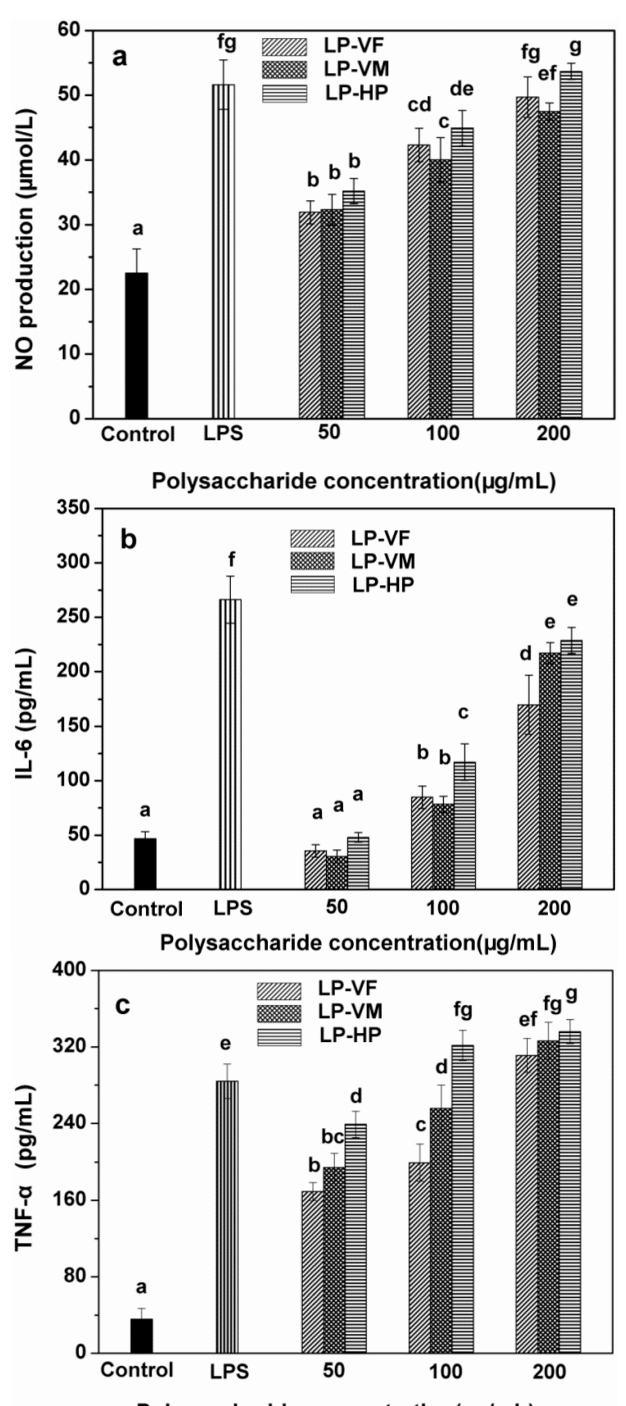
Figure 4. Effects of litchi polysaccharide-protein complexes on the production of NO ( a ), IL-6 ( b ) and TNF- α ( c ) of RAW264.7 macrophages. LPCs (50, 100 and 200 μg/mL) and LPS (5 μg/mL ) were added to stimulate RAW264.7 macrophages. NO, IL-6 and TNF- α were measured by ELISA kits. The results were expressed as the mean ± standard deviation ( n = 6). Bars labeled with different letters represent a statistical difference at p < 0.05. LP-VF: Litchi polysaccharide-protein complexes from vacuum freeze dried pulp; LP-VM: Litchi polysaccharide-protein complexes from vacuum microwave dried pulp; LP-HP: Litchi polysaccharide-protein complexes from heat pump dried